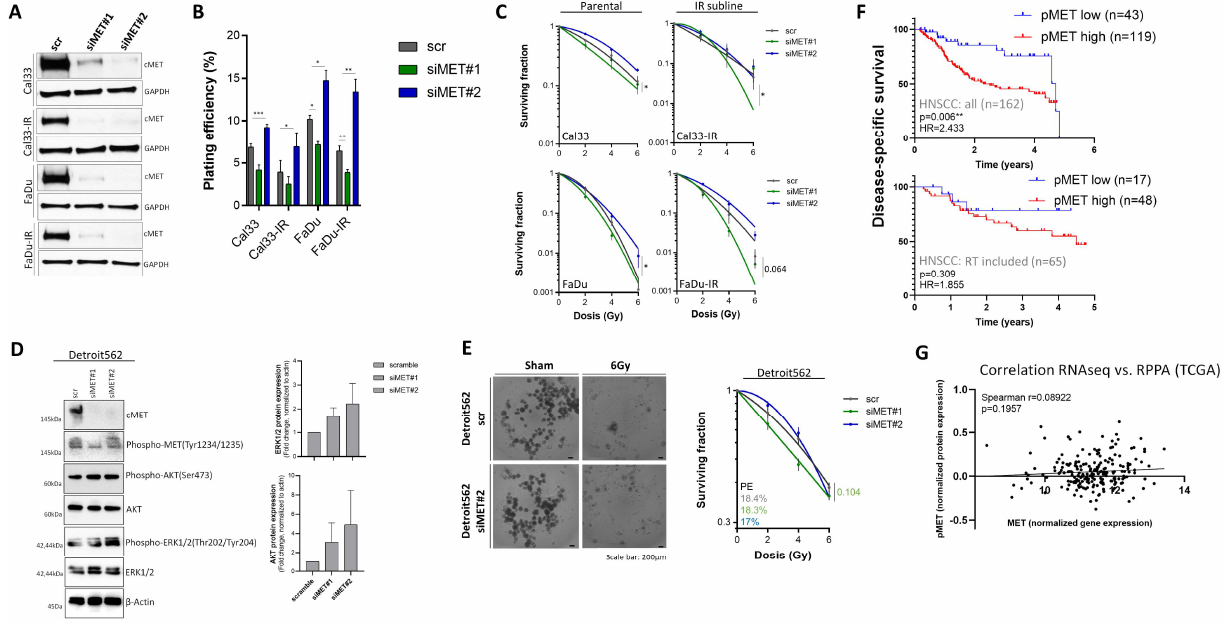
Figure 4. Cellular effects of siRNA-mediated MET -specific gene knock-down in HNSCC cell lines. ( A ) Validation of down-regulated c-MET protein expression 24 h upon transfection with 50 pmol of c-MET specific siRNA#1 and #2 in comparison to unspecific scrambled control (scr). Western blot analysis demonstrated highly efficient c-MET (175 kDa) down-regulation in Cal33 and FaDu as well as their irradiated sublines (IR). Glyceraldehyde 3-phosphate dehydrogenase (GAPDH, 35 kDa) was used as internal loading control ( n = 2). ( B,C ) Clonogenic survival and plating efficiency (b) in standard 2D-colony-assay 10 days after c-MET knock-down for Cal33 and FaDu cell line as well as their irradiated sub-lines (IR) in comparison to scramble (scr) control ( n = 3, * p < 0.05, mean ± SEM). Linear-quadratic model of cell survival curves after irradiation with 0, 2, 4, or 6 Gy (c) ( n = 3, * p < 0.05, mean ± SEM). The number of colonies within 10 days is calculated to plated cell number and depicted as plating efficiency. The surviving fraction illustrates the clonogenic survival depending on the irradiation dose and is normalized to plating efficiency. ( D ) Western blot analysis of Detroit562 cells 24 h after c-MET knock-down validated the effects on c-MET proteins without affecting c-MET phosphorylation and other downstream kinases such as AKT and ERK1/2. β -actin was used as loading control. ( E ) Clonogenic survival of metastasis cell line Detroit562 which originates from pleural effusion (primary origin: pharynx) 10 days after MET knock-down upon transfection with 30 pmol of c-MET specific siRNA#1 or #2 in 3D-matrigel-based cultures treated with increasing doses of irradiation (2, 4, 6, and 8 Gy) ( n = 3, mean ± SEM). ( F ) In silico analysis of TCGA-HNSCC proteome database ( n = 162) for the phosphorylated c-MET (Y1235, pMET) protein analyzed via reverse phase protein array illustrates patient stratification with Kaplan–Meier curves. HNSCC patients with high level of pMET have a significantly lower disease-specific survival in comparison to patients with low pMET level in local tumor biopsies ( p = 0.006, HR = 2.433). Subgroup analysis for HNSCC patients treated with radiotherapy (RT, n = 65) does not show significant differences ( p = 0.309). ( G ) Correlation analysis of MET gene expression with phosphoprotein analysis illustrates no association within the HNSCC-TCGA data set (r =